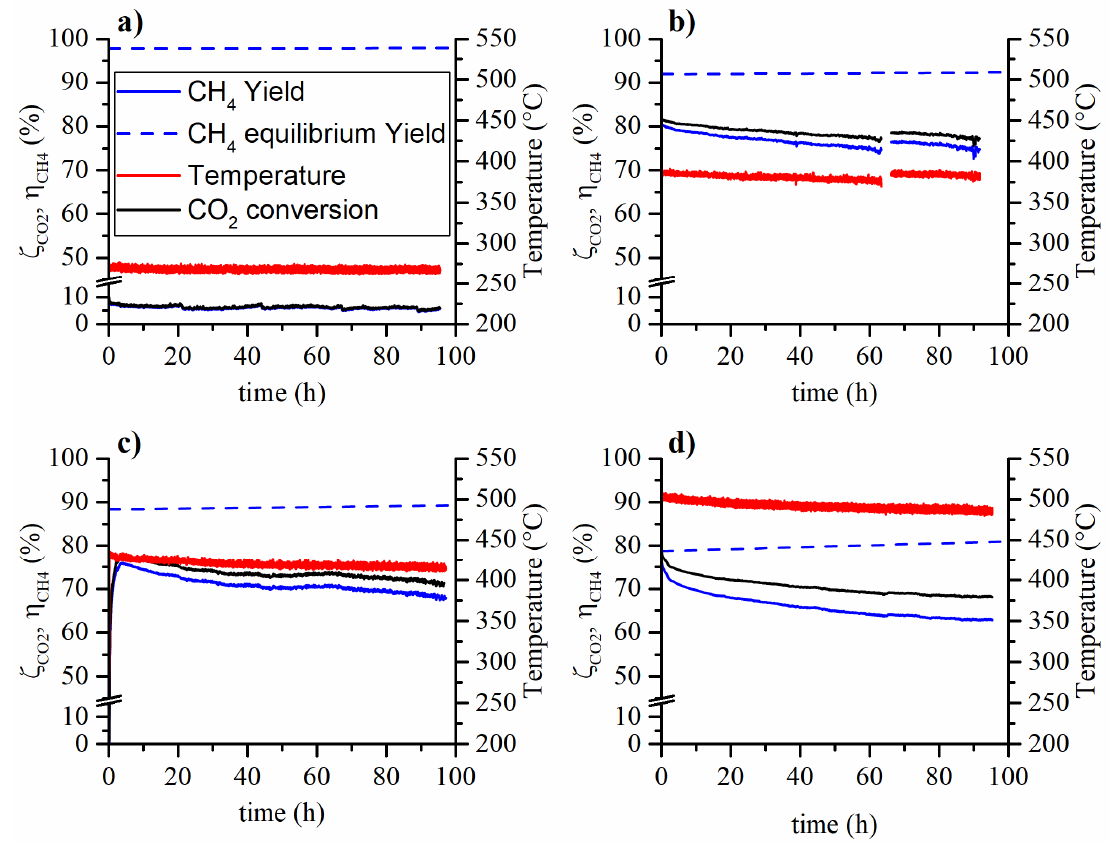
− 1 h , feed composition cat